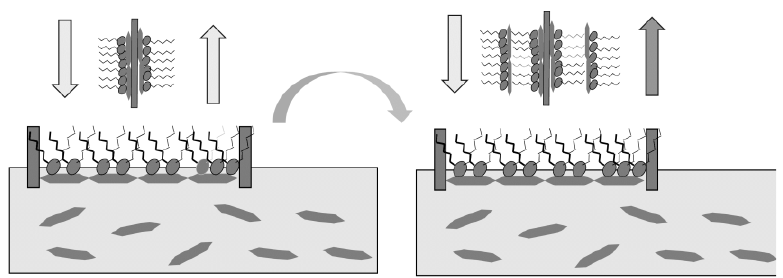
Scheme 2. The layer-by-layer deposition